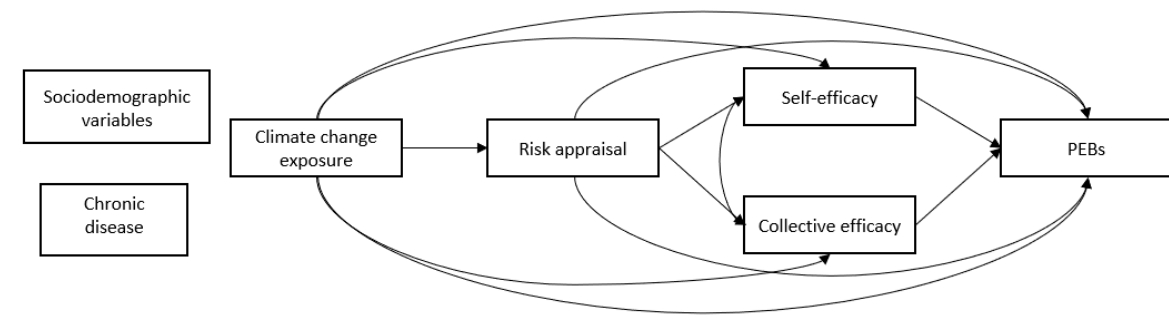
Figure 1. The study’s model.